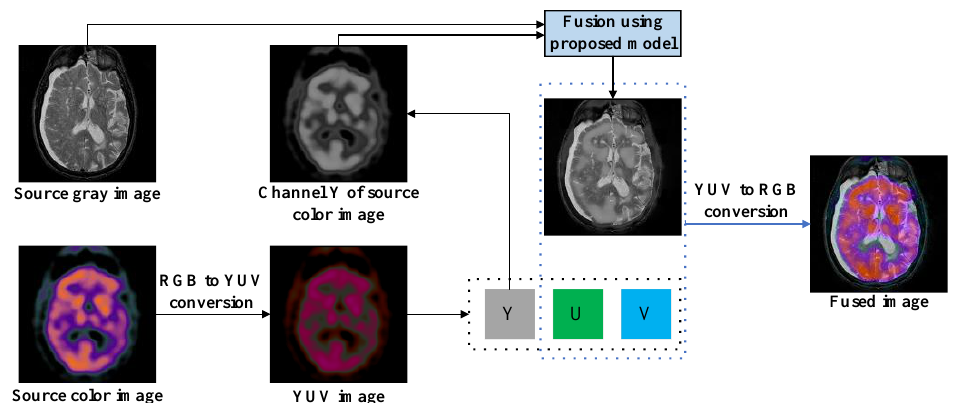
Figure 2. Scheme for fusing medical images with color.